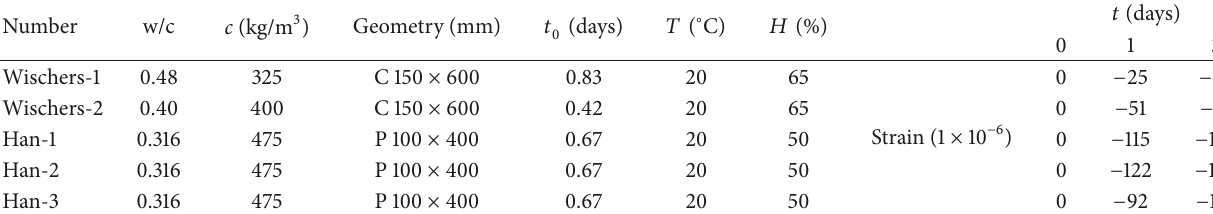
Table 3: Test parameters and